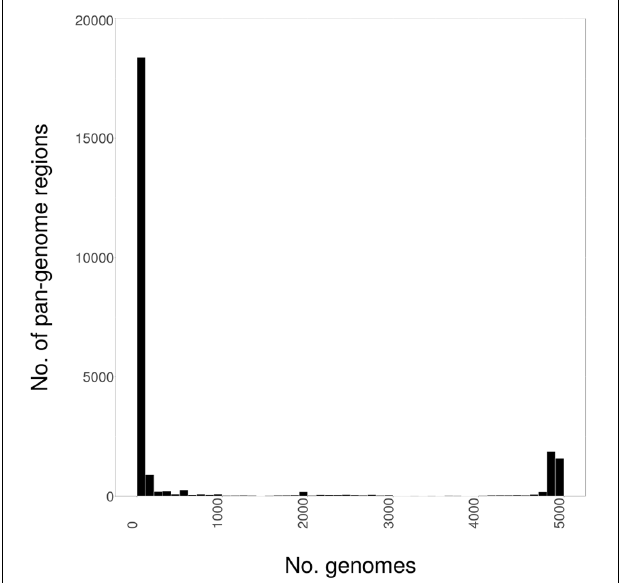
FIGURE 1 | The distribution of the Salmonella enterica pan-genome, as 1000 bp fragments, among 4939 whole-genome sequences (WGSs).